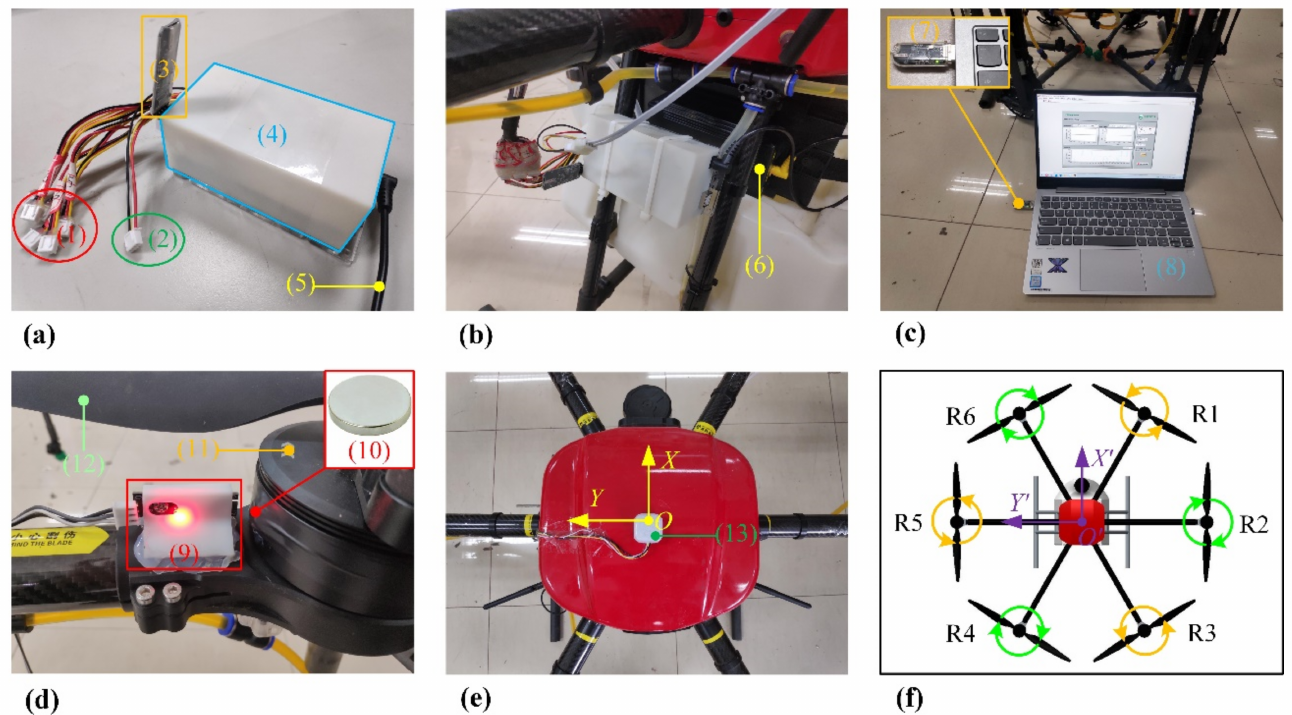
Figure 3. The hardware of WSPM-System. ( a ) Hardware integration; ( b ) installation effect of the Arduino board; ( c ) the laptop with the software of WSPM-System; ( d ) installation effect of the Hall sensor; ( e ) installation effect of the JY61; ( f ) the fuselage coordinate system and rotor number. (1) Hall sensor interface; (2) JY61 interface; (3) TTL-nRF24L01; (4) Arduino board with a 3D printed shell; (5) power cable; (6) lithium battery; (7) USB-nRF24L01; (8) laptop; (9) Hall sensor with a 3D printed shell; (10) magnet; (11) brushless motor; (12) rotor; (13) JY61 with a plastic